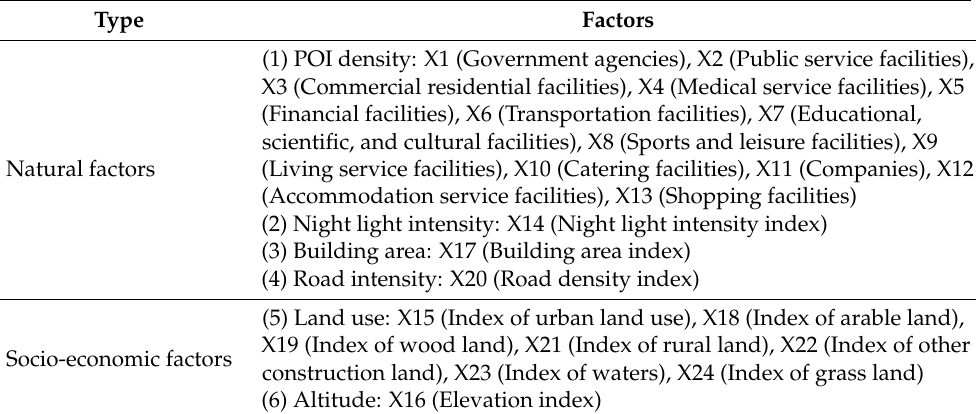
Table 1. Initial influence